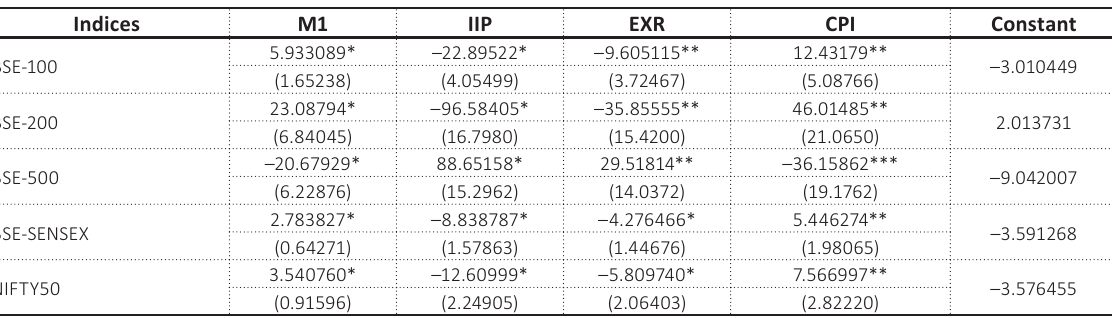
Table 5. Long-term equations